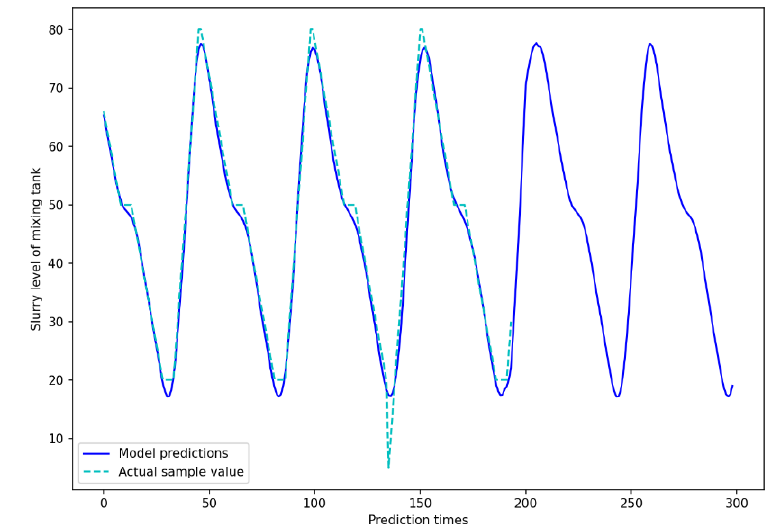
Figure 8. Model prediction result. Table 1. Partial comparison results of actual and predicted values of slurry level in the mixing tank.